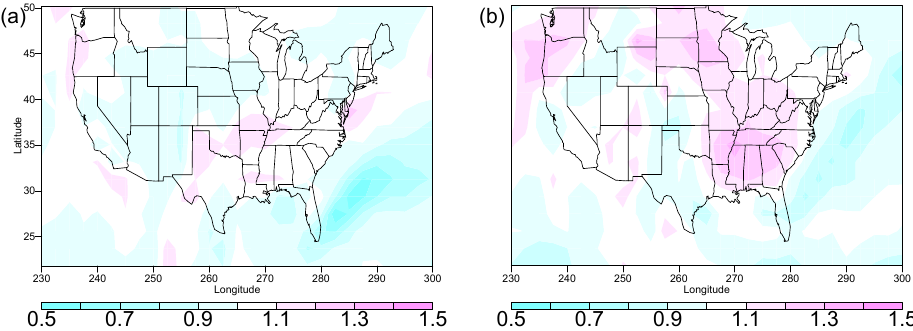
Figure 4. Rescaled data. (a) (cid:57)( O 3 , O 3 ) ; (b) (cid:57)(T,T ) . (See the definition of (cid:57) in Eq. 7).